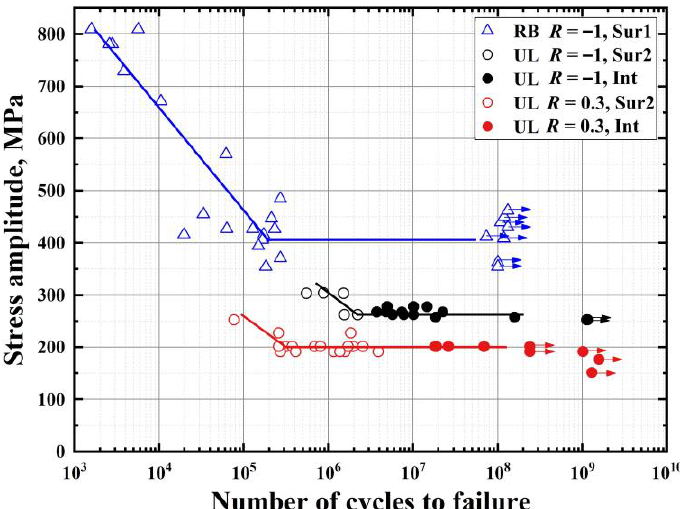
Figure 6. S-N curves of tested specimens under rotating bending and ultrasonic axial cycling with stress ratios of − 1 and 0.3. (RB: rotating bending, UL: ultrasonic loading, Sur1: surface crack initiation without inclusion, Sur2: surface crack initiation with inclusion, Int: internal inclusion, symbol with arrow: not broken).